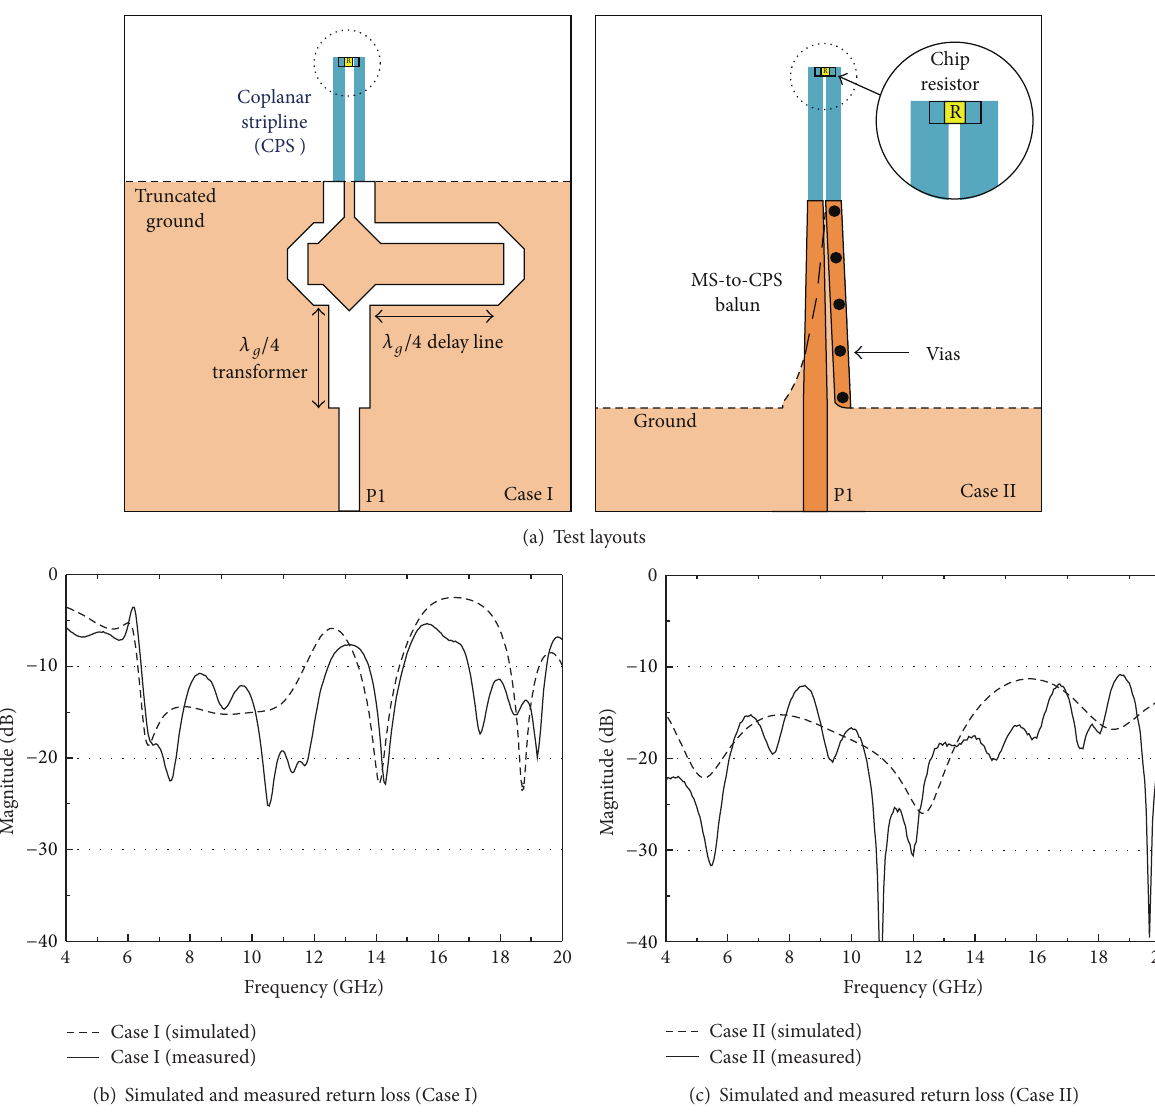
Figure 3: MS-to-CPS baluns terminated with a matched